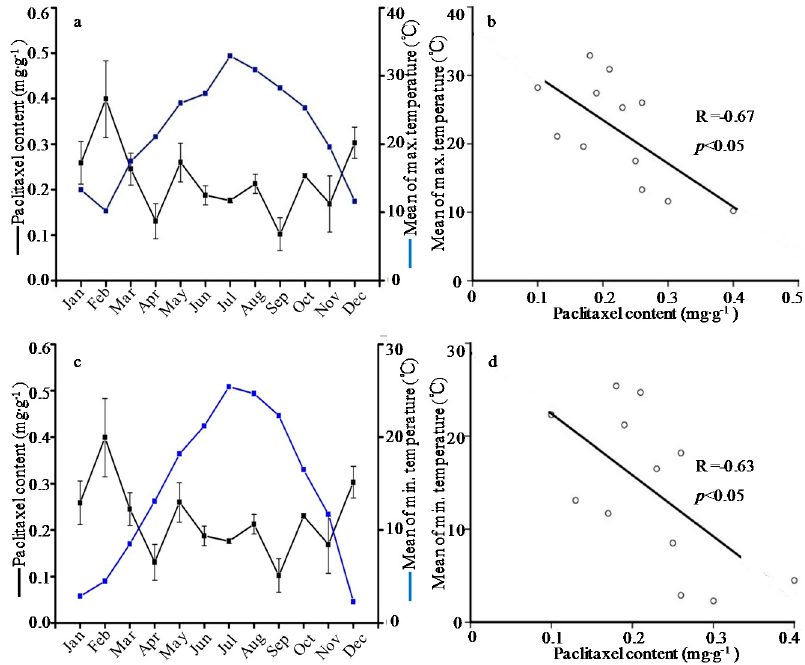
Figure 1. Relationship ( a ) and correlation ( b ) between paclitaxel content and mean of maximum temperature; and relationship ( c ) and correlation ( d ) between paclitaxel content and mean of minimum temperature.